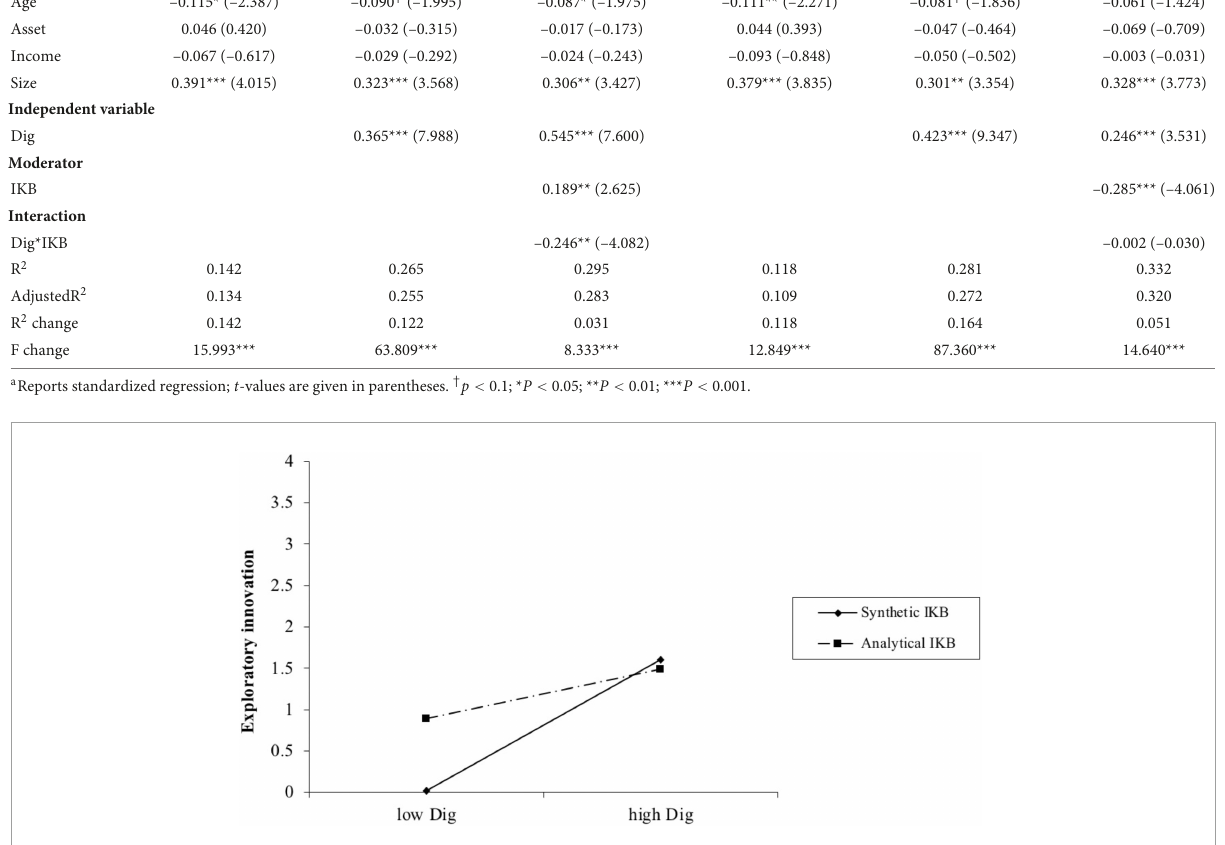
FIGURE2 Industrial difference in the effect of digitalization on exploratory